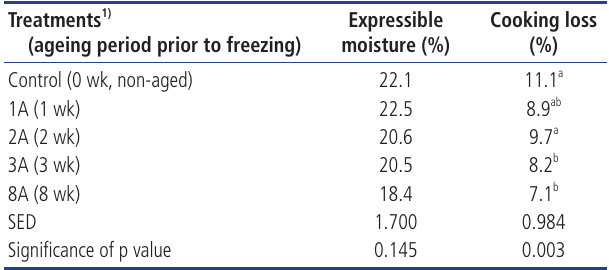
Table 3. Water-holding capacity of model sausages formulated with aged/frozen/ thawed lamb loins Treatments 1)